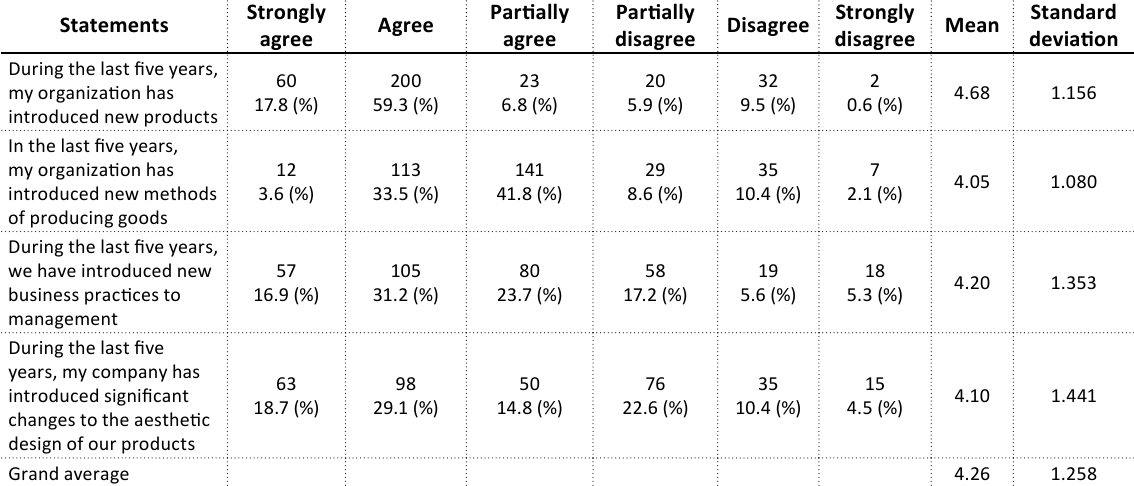
Table 1. Descriptive statistics of innovation strategies